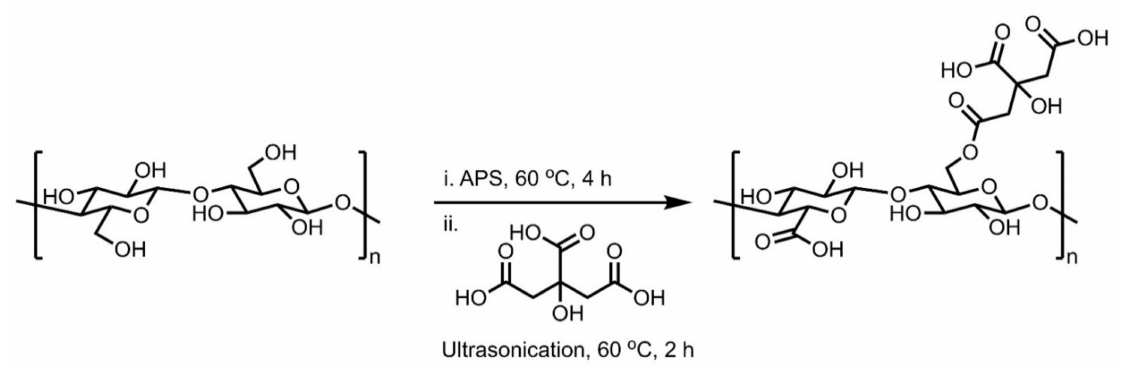
Scheme 5. Reaction of microcrystalline cellulose with APS and citric acid to produce CNCs with dicarboxylic acid moieties